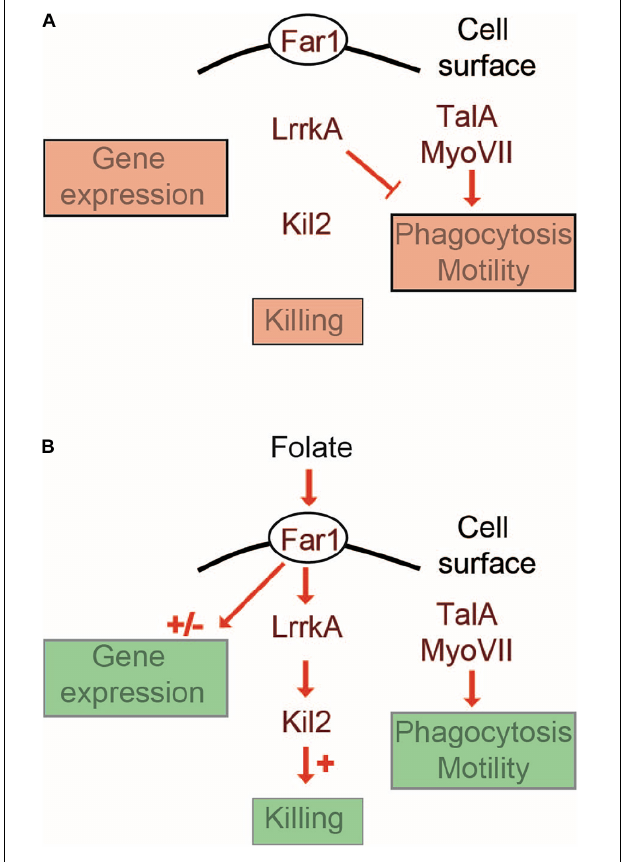
FIGURE 8 | Cellular response to folate: a working model. This schematic overview proposes a minimalist interpretation of the results presented in this manuscript and in previous publications. Far1, the cell surface receptor for folate is essential for all cellular responses to folate. A Far1-LrrkA-Kil2 pathway stimulates intracellular killing in response to folate. LrrkA inhibits cell motility in the absence of folate (A) , and the inhibition is relieved upon stimulation by folate (B) . The transcriptional response to folate operates in an LrrkA-independent